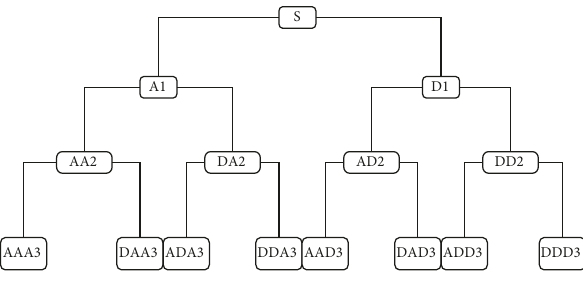
Figure 2: Three-layer binary trees WPD. Table 1: The steps of signals denoising using